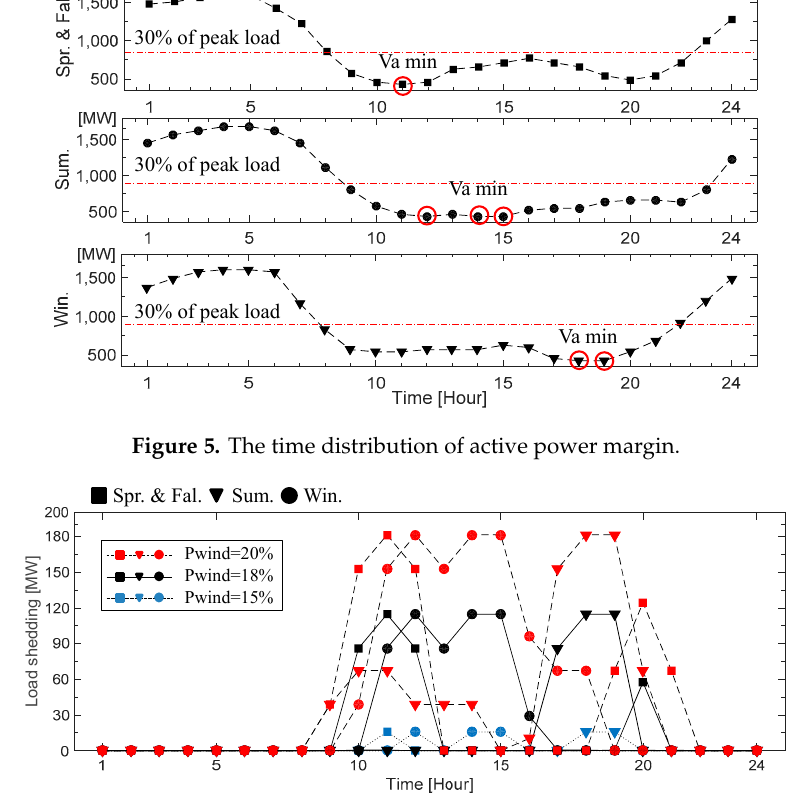
Figure 6. The time distribution of load shedding.